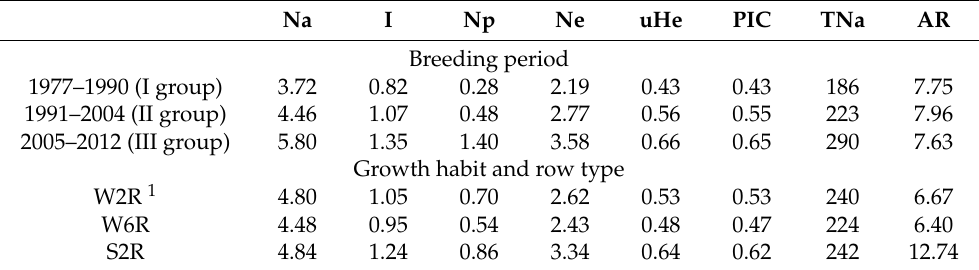
Figure 3. Principal coordinate analysis of 90 barley genotypes based on microsatellite data and the year of release. The historical period of release: green diamond—group I of varieties released from 1973 to 1990; blue square—group II of varieties released from 1991 to 2004; yellow triangle—group III of varieties released from 2005 to 2012. Table 2. Molecular diversity parameters in barley groups according to the breeding period, growth habit, and row